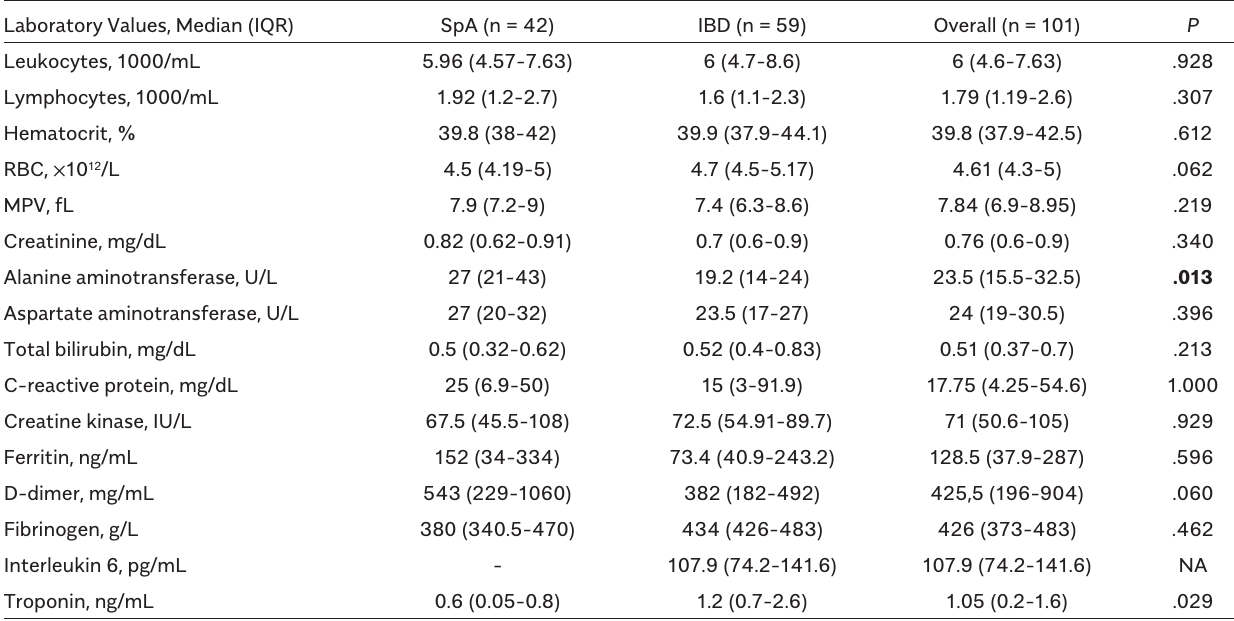
IBD, inflammatory bowel disease; MPV, mean platelet volume; SpA, spond yloar throp athie s; RBC, red blood cell count; IQR, interquartile range; COVID-19, coronavirus disease 2019; NA, not available. P < .05 is